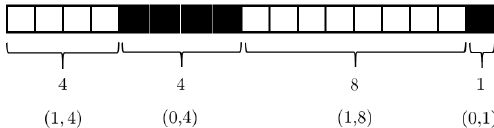
Figure 5. A 1D Run Length Encoding (RLE). The binary sequence is coded as ( 4,4,8,1 ) or rather by the couple-based code ( 1,4 ) , ( 0,4 ) , ( 1,8 ) , ( 0,1 )